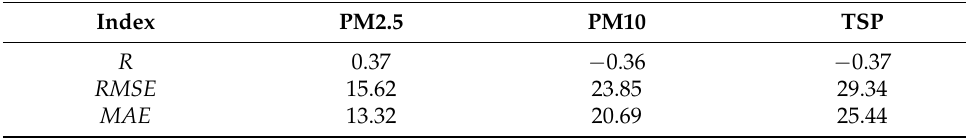
Table 3. Random forest estimation